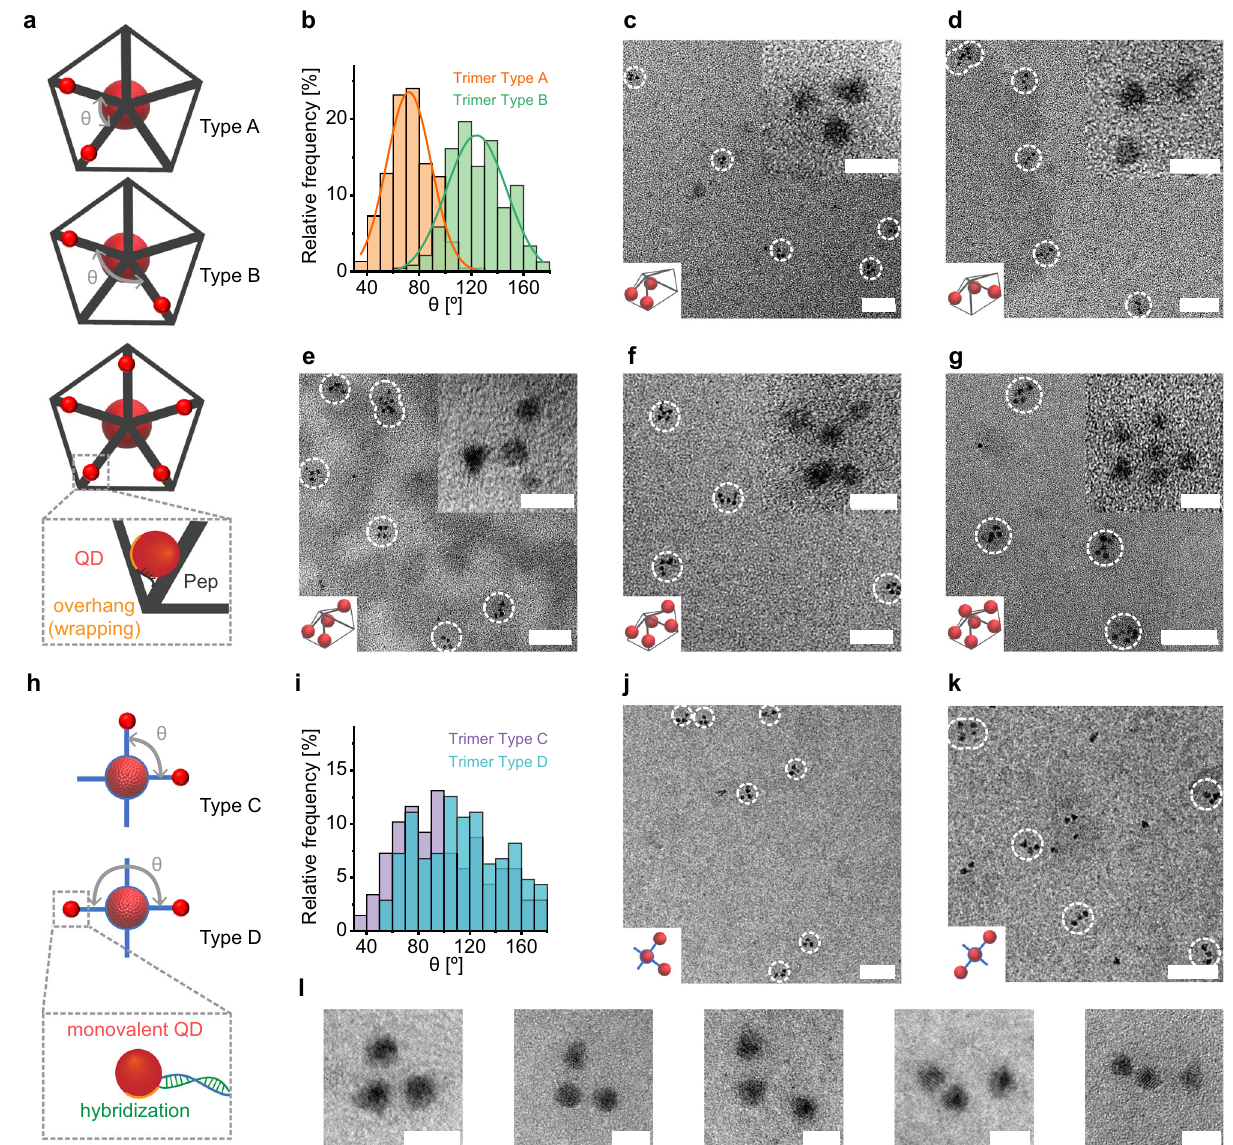
Fig. 6 | Valence-geocoded QD-based colloidal molecules. a Schematic of Pep- based QD assemblies, the theoretical angle of θ for QD trimer Type A and Type B, and the overhang design. b Distributions of bond angles of randomly selected QD trimer in TEM images (233 NPs for Type A, 238 NPs for Type B, solid curve are Gaussian fi ttingofthedistribution).TEM,HRTEM(insetupperright)andschematic (insetbottomleft)imageforQDtrimer c TypeAand d TypeB, e QDtetramer, f QD pentamerand g QDhexamer. h Scheme forDNA complexes-based QDassemblies,